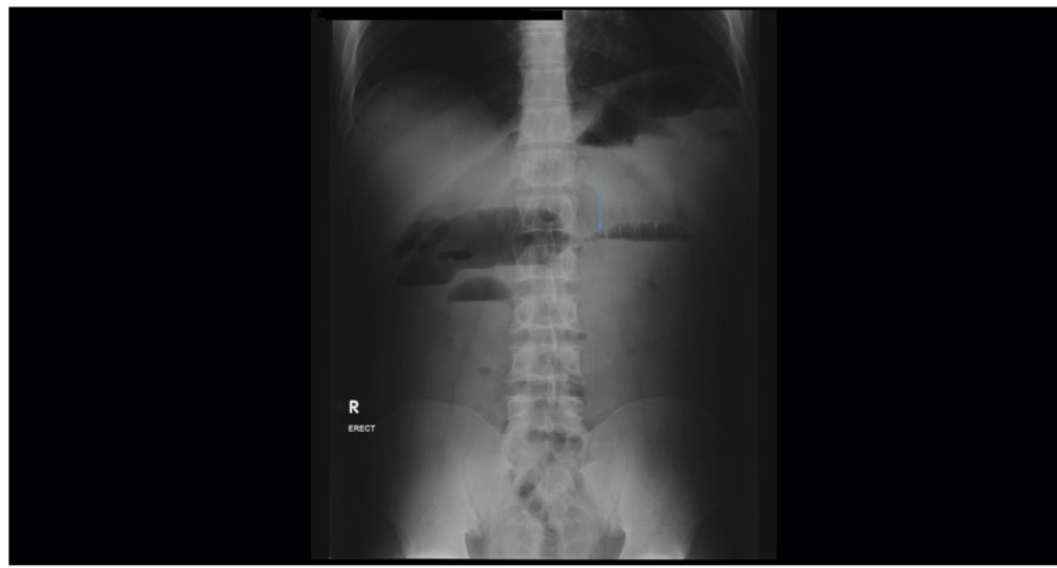
Figure 2: Erect abdominal radiograph: Small bowel dilatation with multiple air fluid levels at different heights with string of beads sign (arrow) in keeping with definite small bowel obstruction